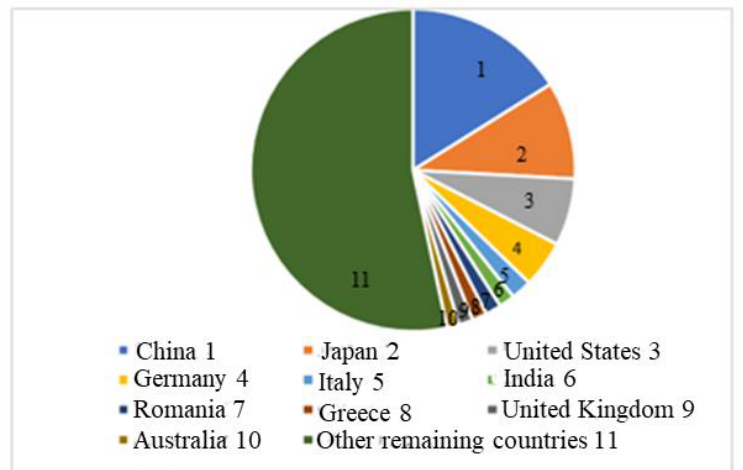
Figure 6. Newly installed PV capacity in ten leading countries and other remaining countries of the world [99].